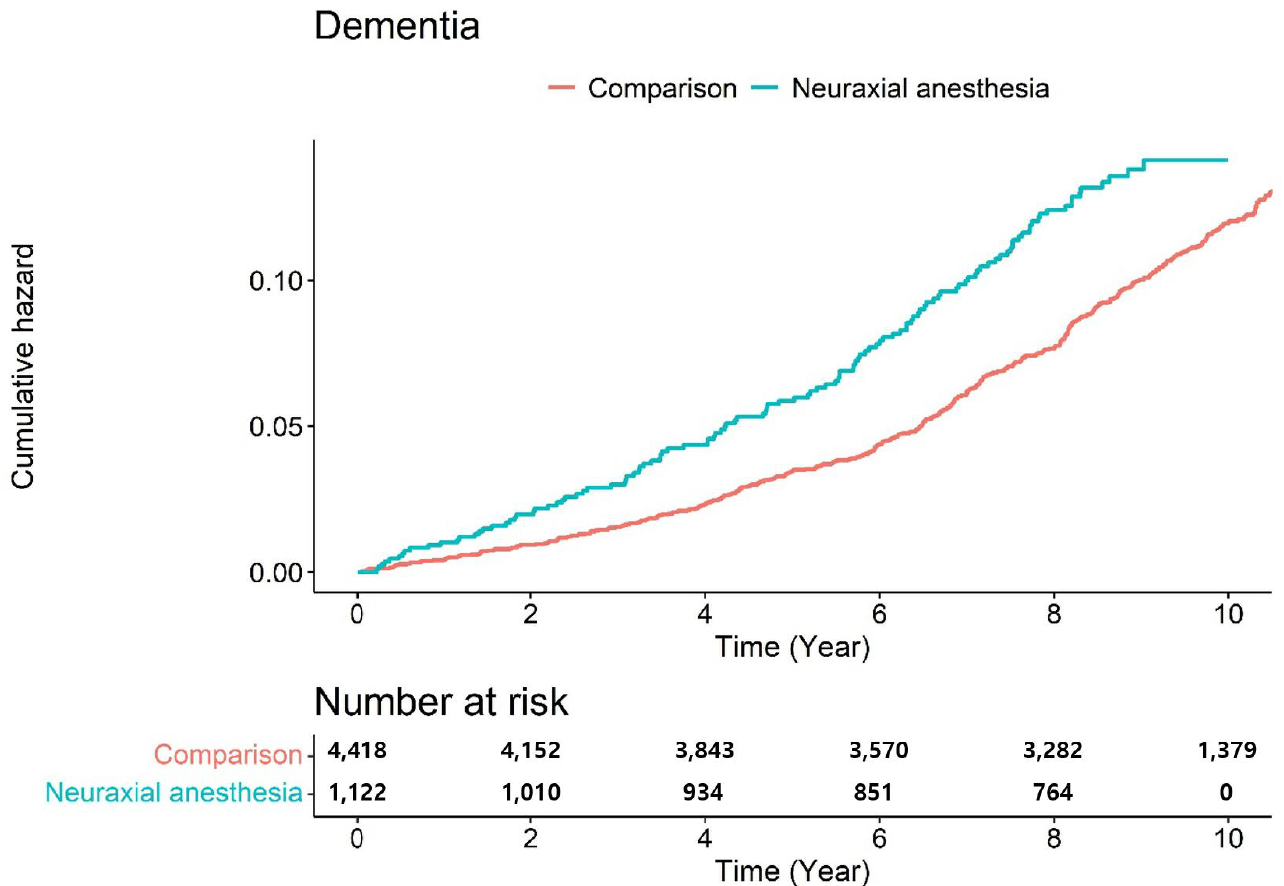
Figure 3. Risk of development of dementia disease between neuraxial anesthesia and comparison (non-anesthesia).